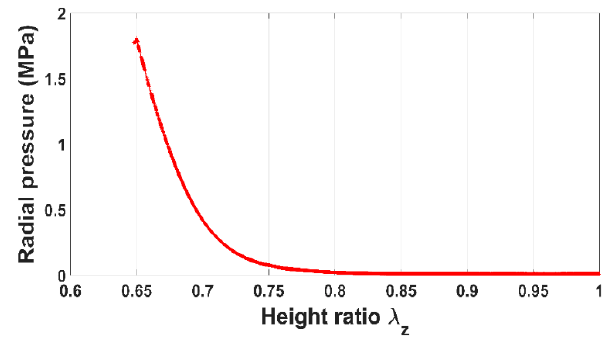
Figure 6. Radial pressure vs. height ratio.